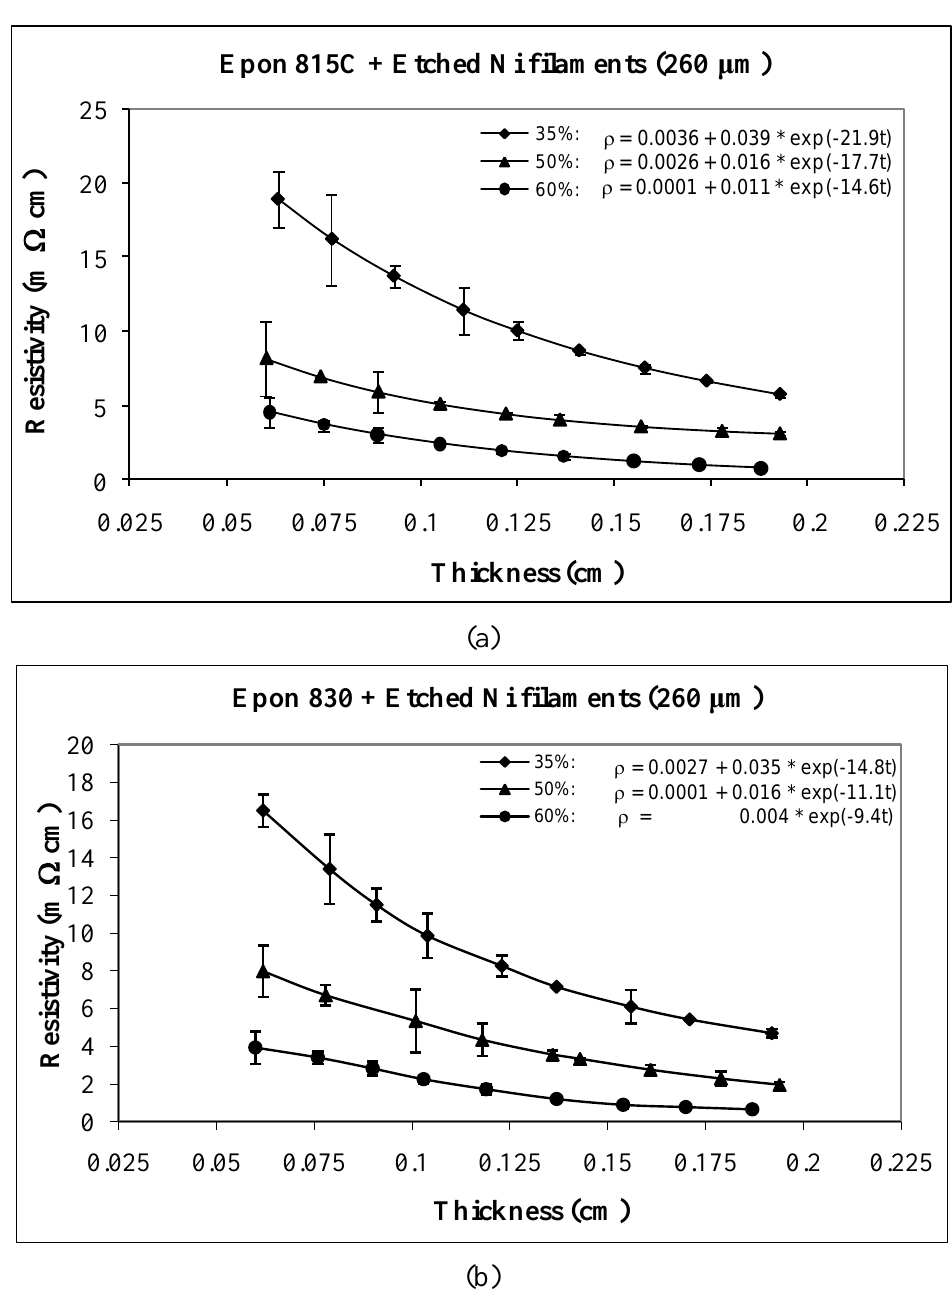
Figure 12. Thickness-dependent resistivity of Epon 815C ( a ), and 830 ( b ) films filled 35%, 50%, 60% by volume with etched nickel filaments (260 